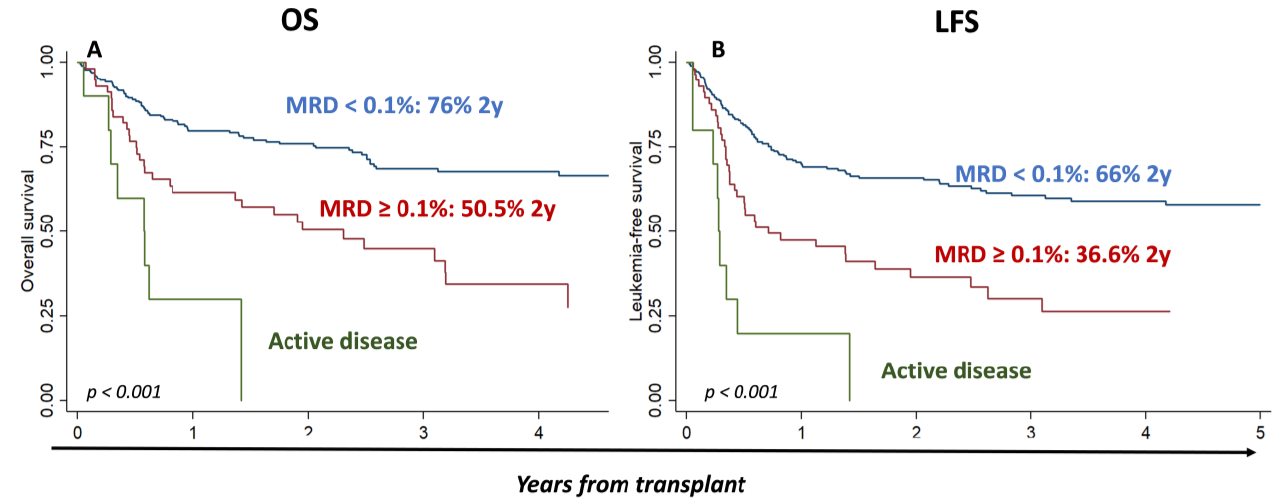
Figure 1. Impact of MRD levels in OS and LFS, considering MRD < 0.1%, MRD ≥ 0.1%, and group of active disease.